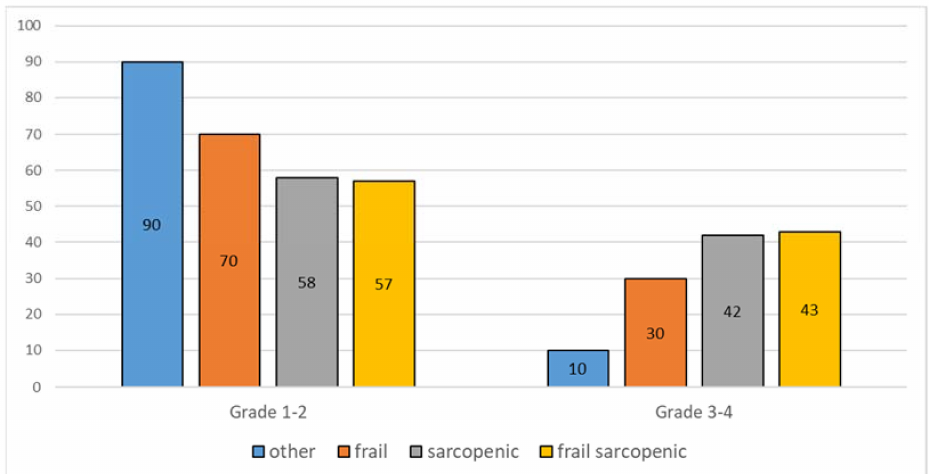
Figure 3. Percentage of patients who experienced Grade 1–2 and Grade 3–4 toxicities (according to Common Terminology Criteria for Adverse Events, CTCAE) in our